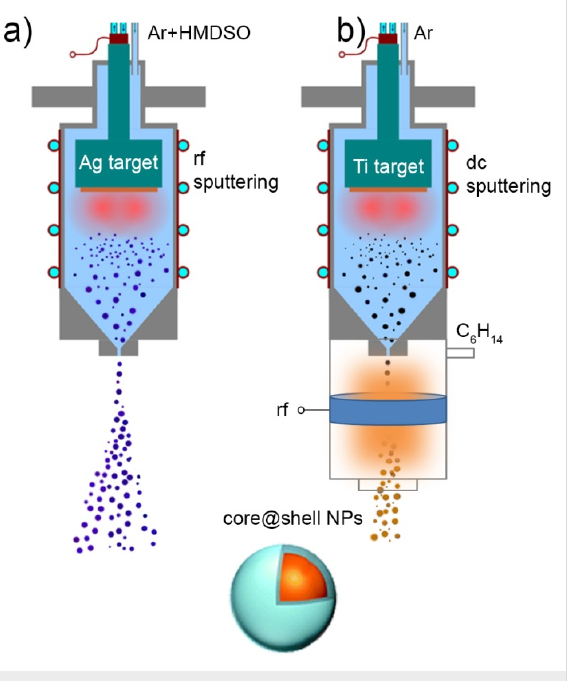
Figure 12: Scheme of synthesis of core@shell NPs by GAS: a) core@shell NPs are produced in the GAS by RF magnetron sput- tering of Ag target in the gas mixture of Ar and HMDSO; b) metal NPs are produced by DC magnetron sputtering of Ti target in the GAS